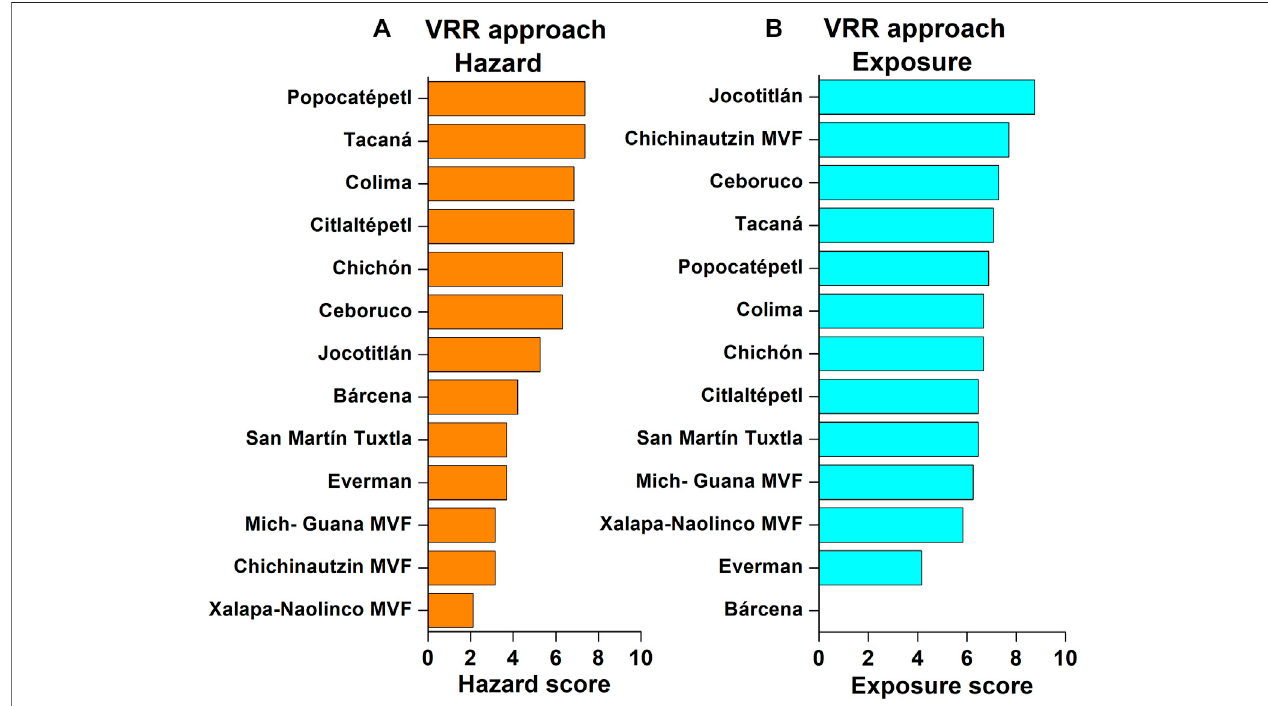
FIGURE 2 | (A) Hazard and (B) exposure analysis based on the new ranking strategy for Mexican volcanoes having erupted < 1 ka.